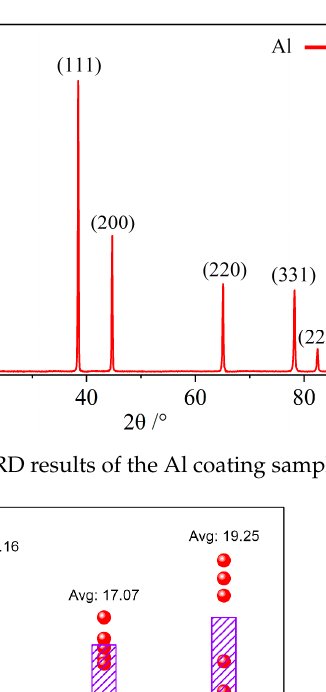
Figure 9. ( a , b ) SEM micrograph of the Al coating sample (~0.30 mm) after the immersion test for 3 months. EDS results of some areas in the figure are provided in ( c ).